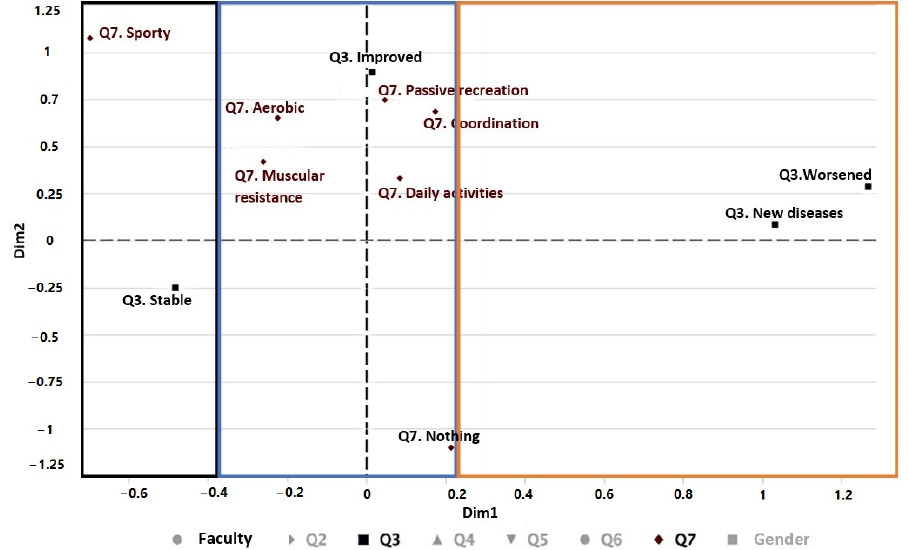
Figure 5 . Multiple correspondence analysis (MCA) of the variables of faculty, Q3, and Q7. Figure 5. Multiple correspondence analysis (MCA) of the variables of faculty, Q3, and